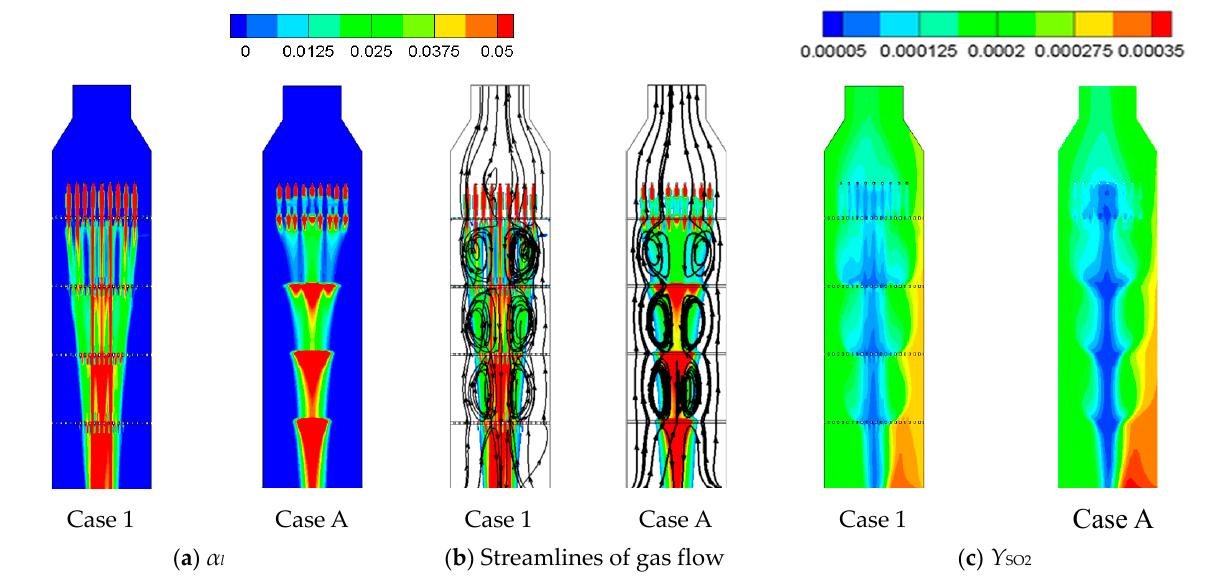
Figure 7. The figure displays ( a ) the liquid volume fraction, ( b ) streamlines of gas flow, and ( c ) the mass fraction of SO 2 within the right tower of the small-scale FGD facility for Case 1 (real perforated structure) and Case A (porous media model).